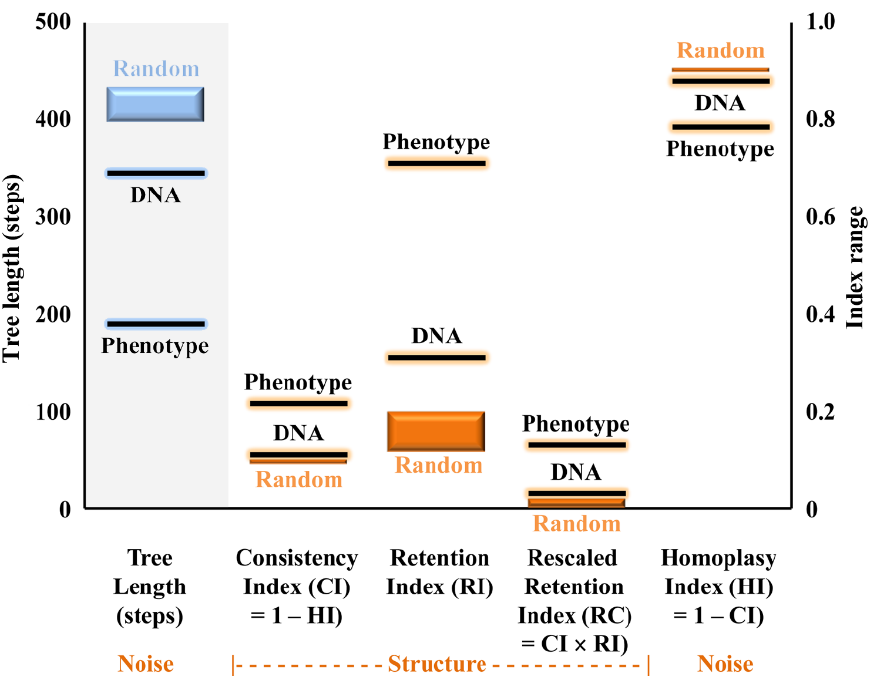
Figure 11. Analyses showing TL, CI, RI, RC, and HI indices derived from phenotypic characters comparing random (Random), DNA-based (DNA), and phenotype-based (Phenotype) trees, assuming that DNA-based trees represent the underlying “true” phylogeny. For DNA-based trees, the corresponding index is always between that of random and phenotype-based trees, but in all cases closer to the random trees, indicating that phenotype structure correlates little with deeper nodes and mostly with terminal